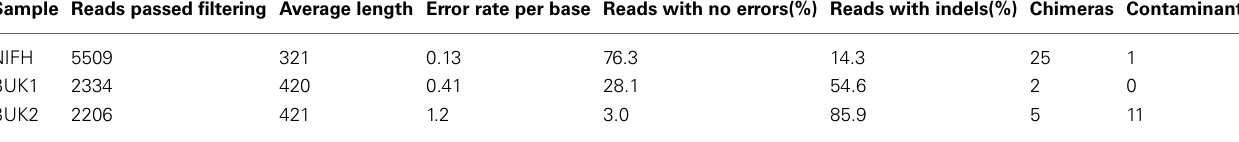
Table 7 | Summary information for the three defined community